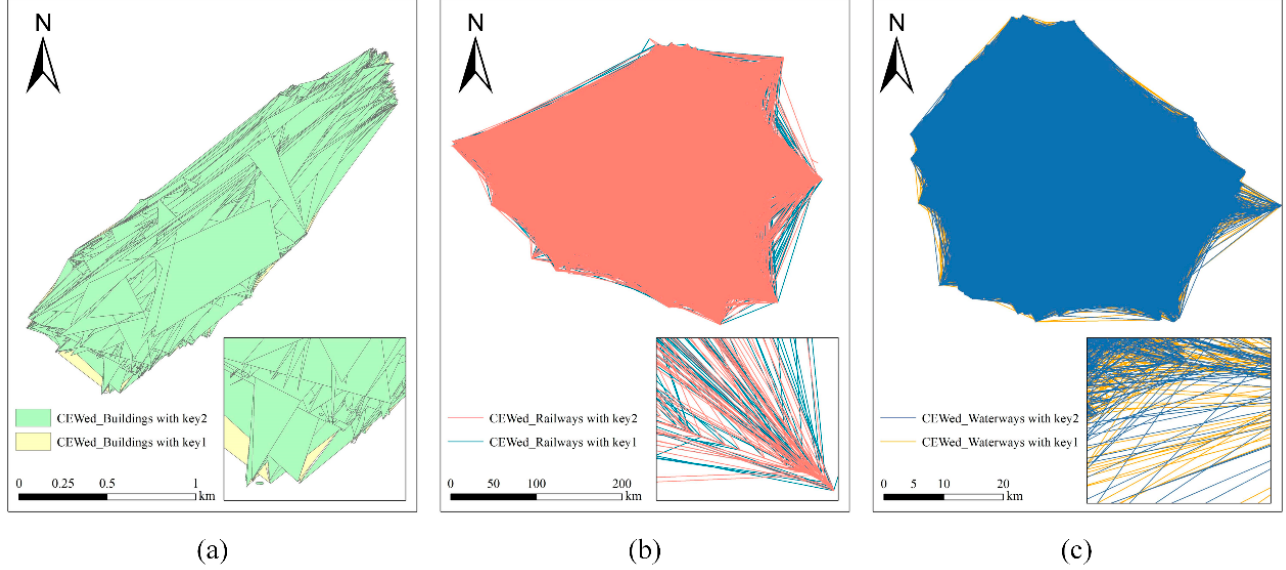
Figure 9. The encrypted maps using different keys: ( a ) encrypted buildings using k 1 and k 2 , ( b ) encrypted railways using k 1 and k 2 , ( c ) encrypted waterways using k 1 and k 2 .